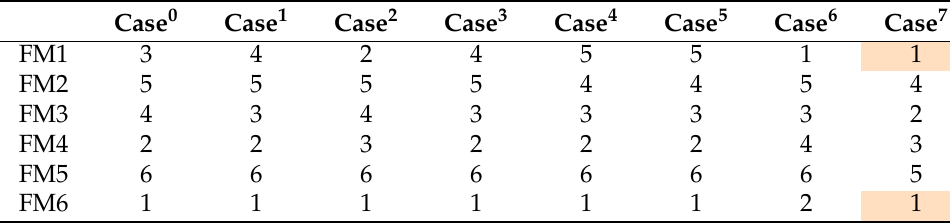
Table 15. Final ranks of studied cases for sensitivity